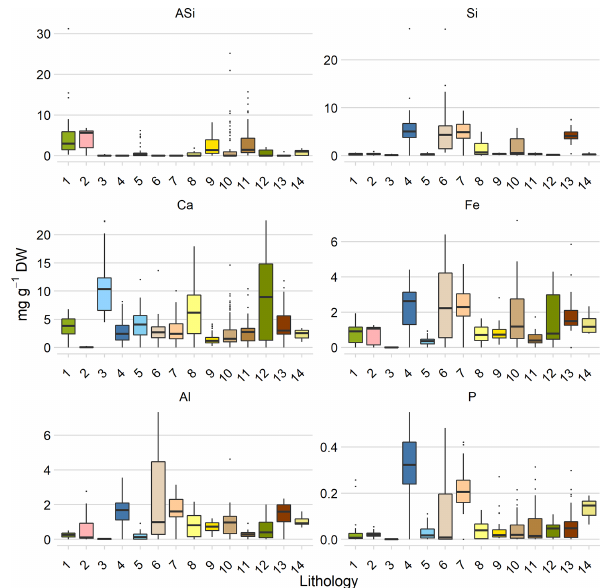
Figure 2. Element concentrations related to lithology. Lithology class 1 is igneous, class 2 is metamorphic, and the other classes are either sedimentary or sedimentary and mixed. Each color represents a bedrock lithology. “1” denotes basalt, olivine basalt, tholeiite, al- kali basalt, basanite, pillow basalt, and flood basalt ( n = 26). “2” represents gneiss and migmatite; reworked amphibolite and gran- ulite facies rocks ( n = 11). “3” shows limestone, dolostone, shale, evaporites, and chalk; carbonate reefs or metamorphosed equiv- alent ( n = 24). “4” denotes limestone, dolostone, shale, evapor- ites, and chalk; carbonate reefs; metamorphic grade not identified ( n = 58). “5” represents limestone, dolostone, shale, evaporites, and chalk; carbonate reefs ( n = 64). “6” shows quartz sandstone, siltstone, claystone, limestone, dolostone, conglomerate, and tillite ( n = 13). “7” denotes sandstone, siltstone, shale, and coal; plant fossils; metamorphic grade not identified ( n = 68). “8” represents sandstone, siltstone, shale, and limestone ( n = 38). “9” shows sand- stone, siltstone, shale, and limestone; metamorphic grade not iden- tified ( n = 39). “10” denotes sandstone, siltstone, and shale; marine fossils ( n = 91). “11” represents sandstone, siltstone, and shale; ma- rine fossils; metamorphic grade not identified ( n = 60). “12” shows sedimentary and/or volcanic rock; undivided ( n = 21). “13” de- notes shale, chert, iron formation, greywacke, turbidite, argillaceous limestone, and matrix-supported conglomerate ( n = 43). “14” rep- resents shale, chert, iron formation, greywacke, turbidite, argilla- ceous limestone, and matrix-supported conglomerate or metamor- phosed equivalent ( n = 8). All values are given as the mean and standard error. The distribution of the lithological classes is shown in Fig. 1, and the assignment to the geographic domain is given in Table S5.